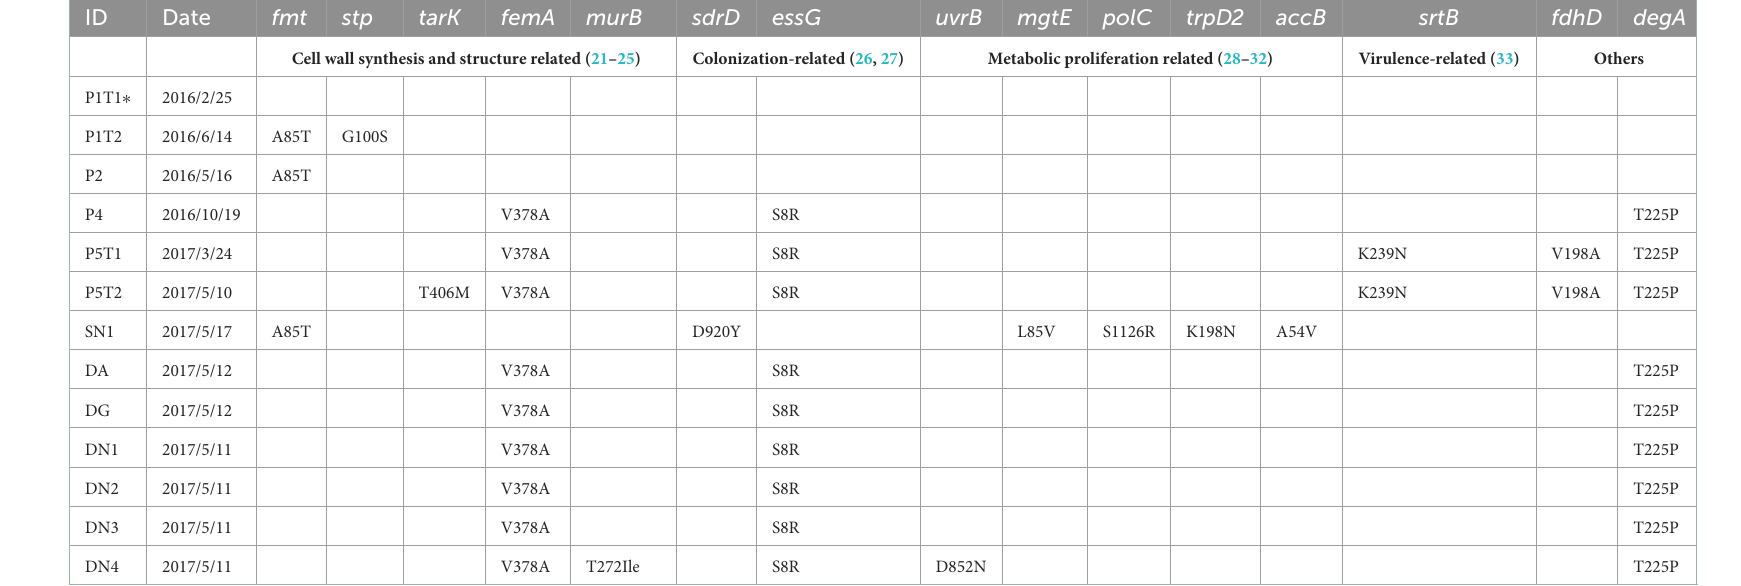
TABLE 3 Specific amino acid difference sites of ST88-MRSA isolates in this